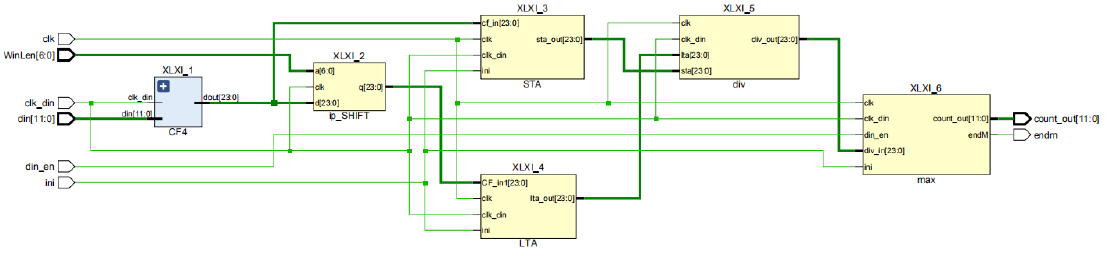
Figure 15. RTL top-level schematic of the arrival time extraction module.